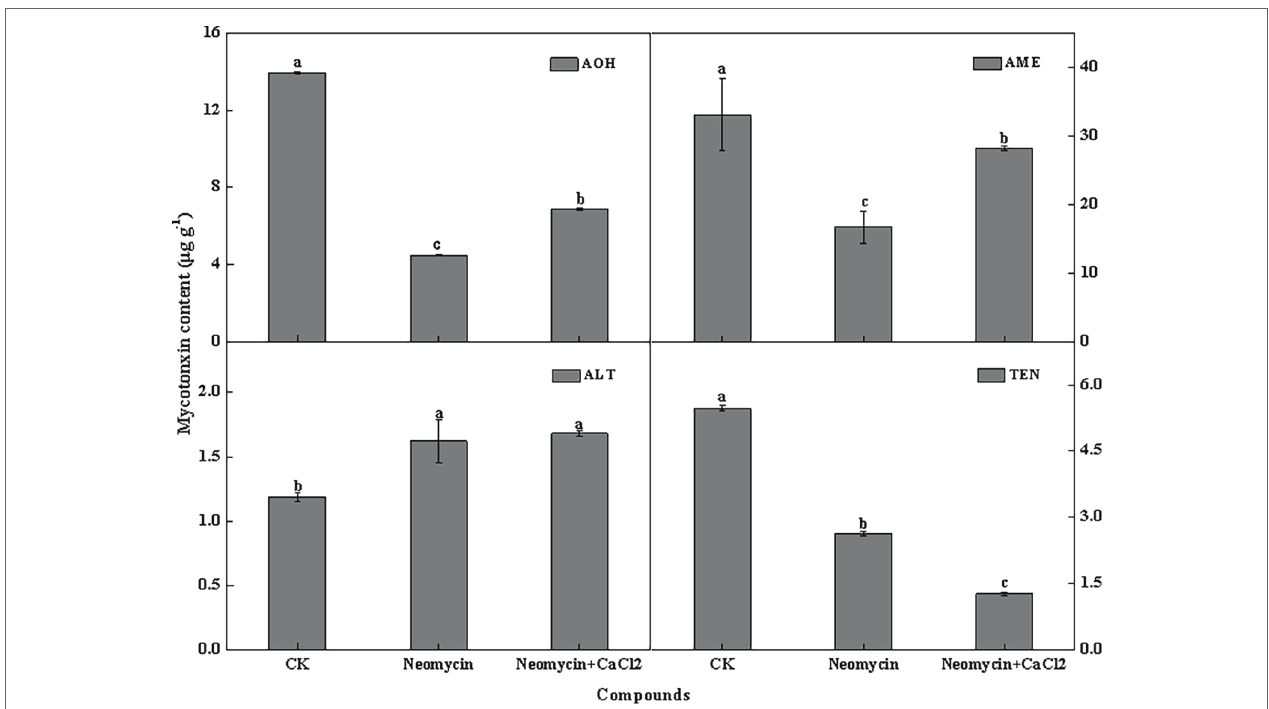
FIGURE 8 | Alternariol monomethyl ether (AME), alternariol (AOH), altenuene (ALT), and tentoxin (TEN) content of A. alternata treated with neomycin and exogenous Ca 2+ . Metabolites were assessed in triplicate. Vertical lines indicate the standard error (± SE ) of the means. Different letters indicate significant differences between treatments ( p <